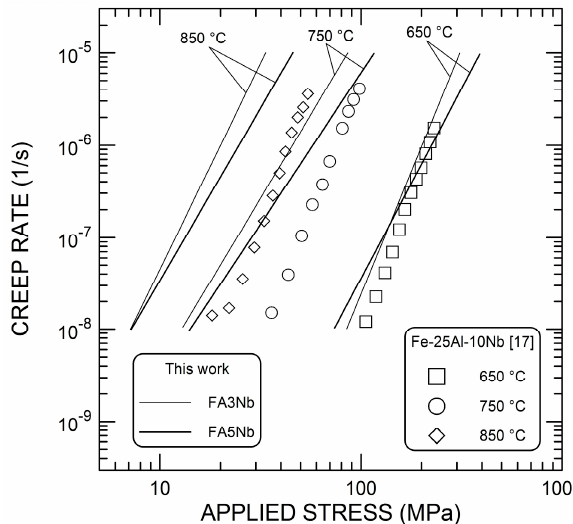
Figure 10. Comparison of the creep rate variation with the applied stress for the present alloys and Fe-Al-based eutectic alloy containing 10% Nb addition [17].